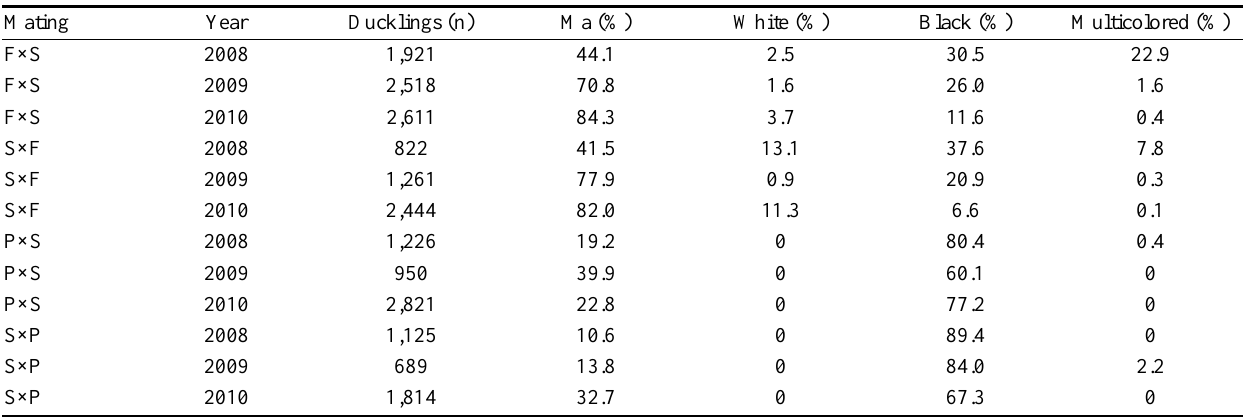
White = Yellow down color and white adult plumage. Multicolored = Undefined color